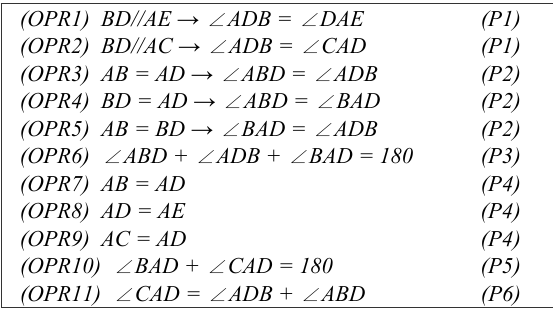
Fig. 4b. Some of the inference operators produced for the sample problem in Fig. 4a.